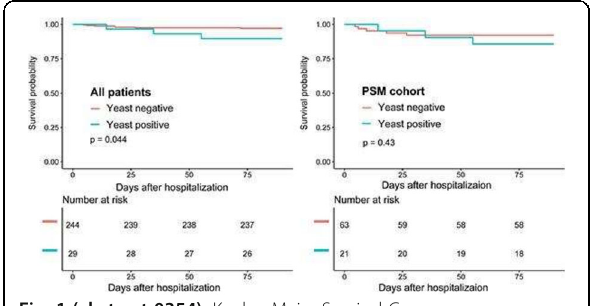
Fig. 1 (abstract 0354). Kaplan-Meier Survival Curve